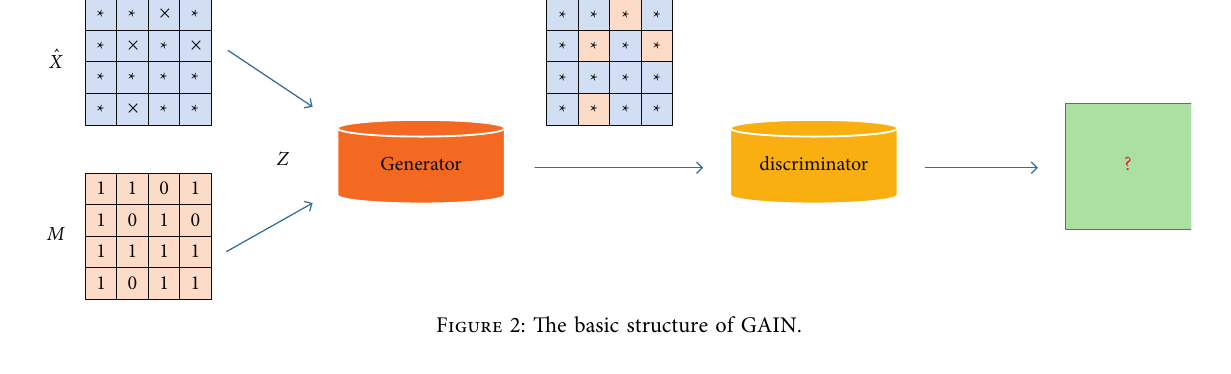
Figure 2: The basic structure of